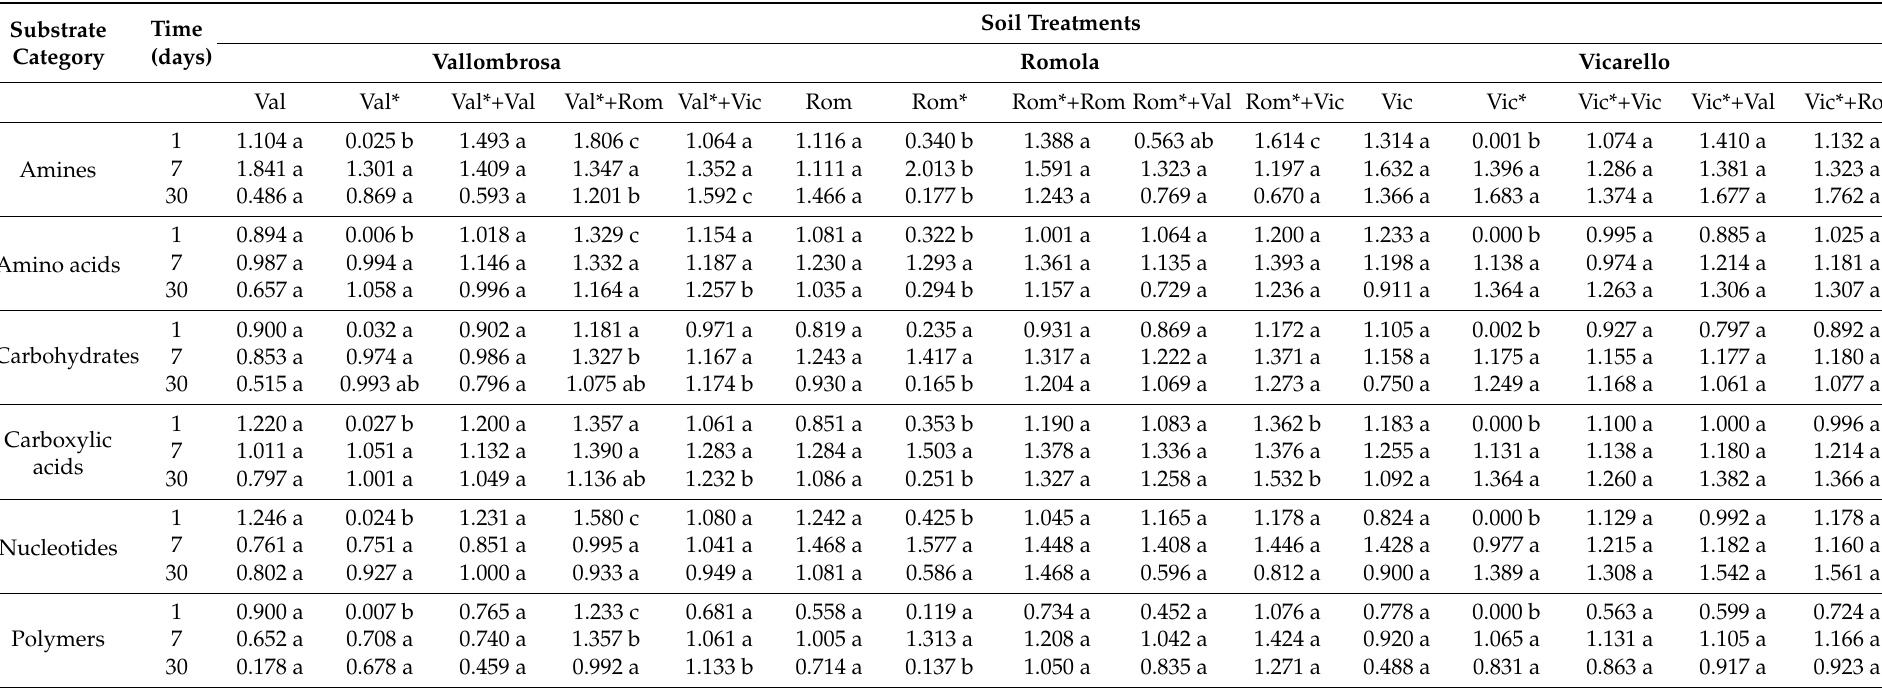
Table 4. Fungal catabolic activity of self- or cross-inoculated soils during a 30-d incubation experiment. Heat-sterilized and non-inoculated soils (Val*, Rom*, Vic*) together with non-sterilized and non-reinoculated soils (Val, Rom, Vic) were taken as control treatments. At each sampling time, different letters indicate a significant ( p < 0.05) difference among means (n =